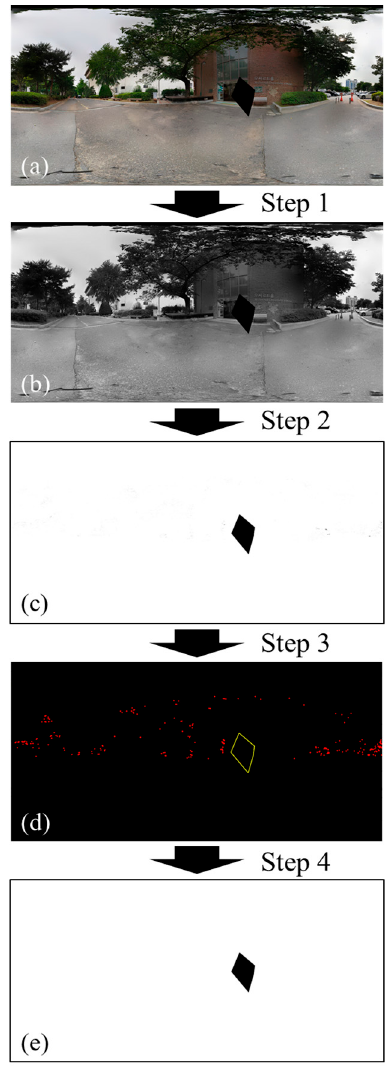
Figure 3. Process to detect the hole in an ERP image: (a) A stitched picture including a hole; (b) a black-and-white picture; (c) a binary image resulted from Step 2; (d) several contours of the candidate holes in the binary picture; (e) the map indicating the decided holes.